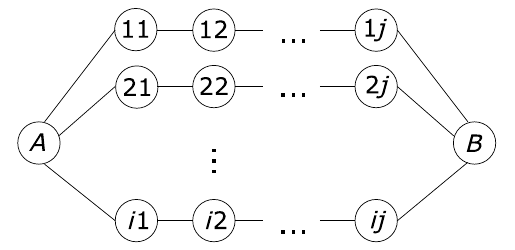
FIG. 1. An example of multiple nonoverlapping paths (MNOPs), demonstrating the labeling of the nodes in MNOPs between A and B